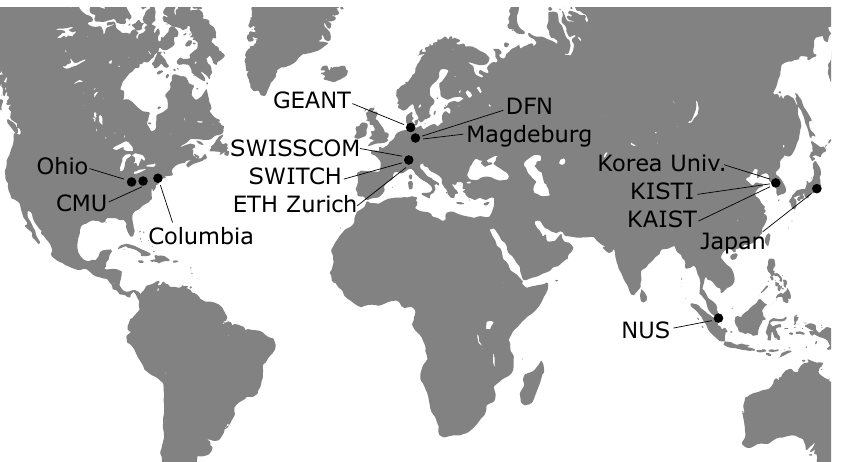
Figure 3. The nodes used for the evaluation with the 6 participating countries including 18 participat- ing SCION ASes. Some dots have several nodes. The nodes Ohio and Japan are deployed on Amazon Web Services